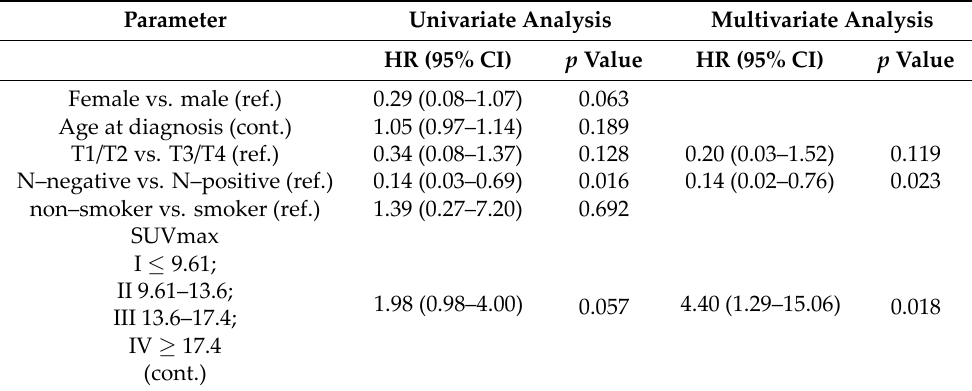
Table 1. Prognostic impact of selected parameters on overall survival of 62 patients with ASCC treated with CRT. Parameter Univariate Analysis Multivariate